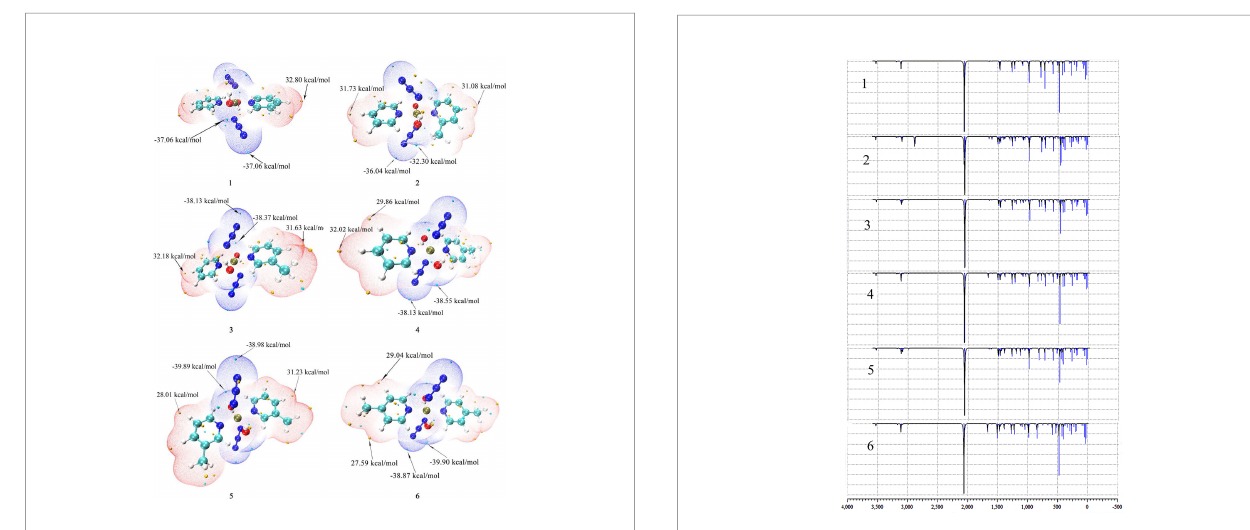
FIGURE 4 | Thecalculatedinfraredspectraofthecompounds1, 2, 3, 4,5and6.